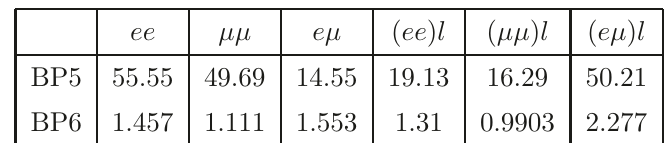
Table 12. Flavour composition of 2- and 3-displaced leptons in the tracker.